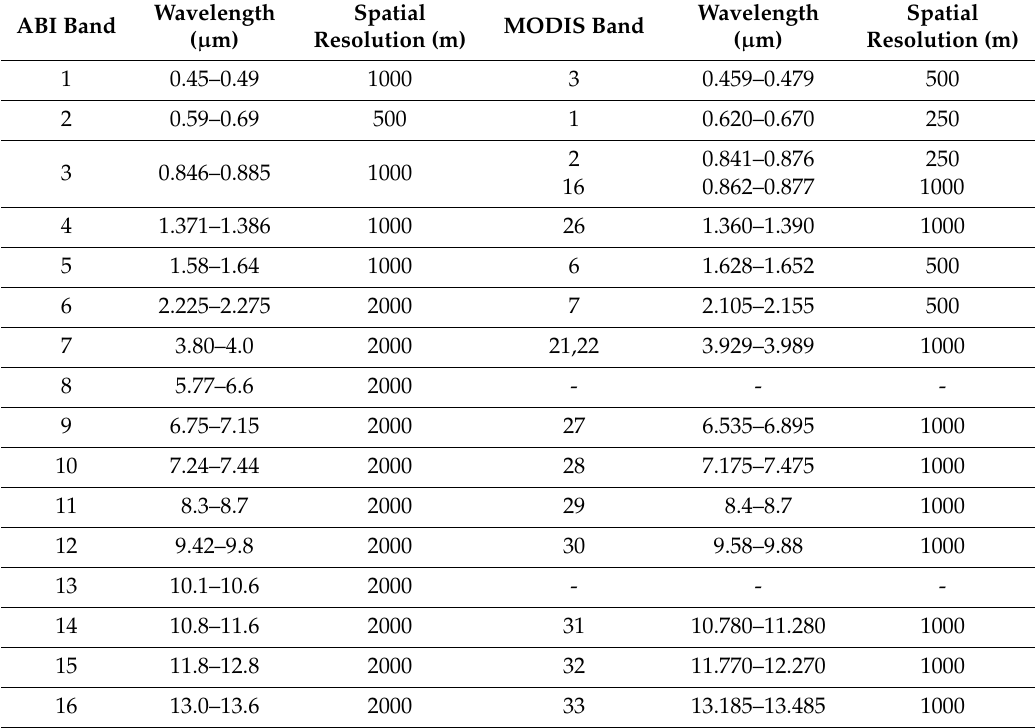
Table 1. Moderate resolution imaging spectroradiometer (MODIS) o ff ers many close spectral matches with the advanced baseline imager (ABI)